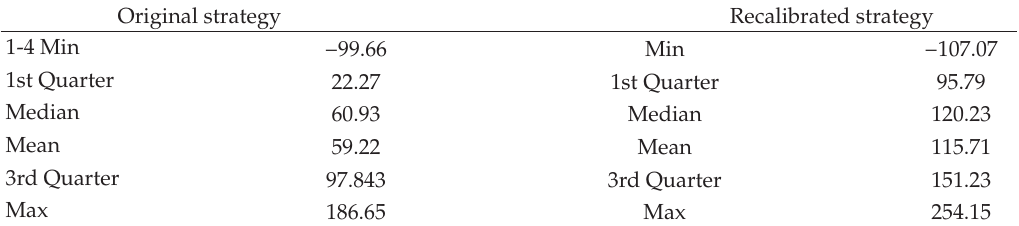
Table 4: Return statistics for original and recalibrated strategies (cid:6) 200 simulated S&P 500 Index paths